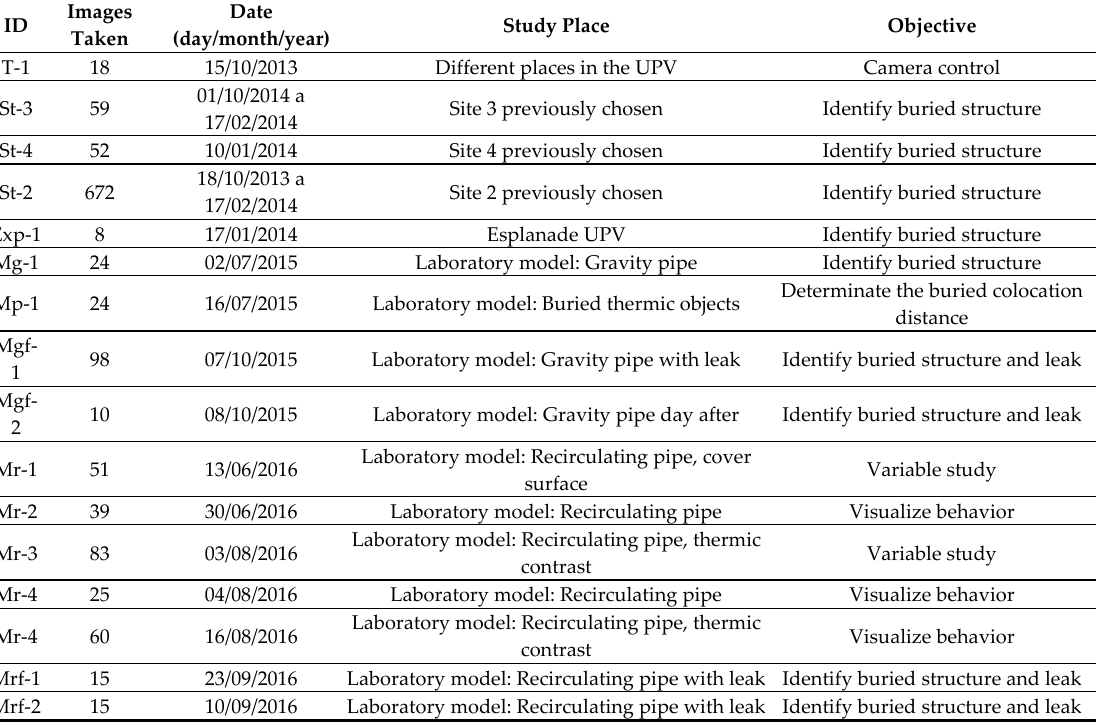
Table 1. All the tests performed during the